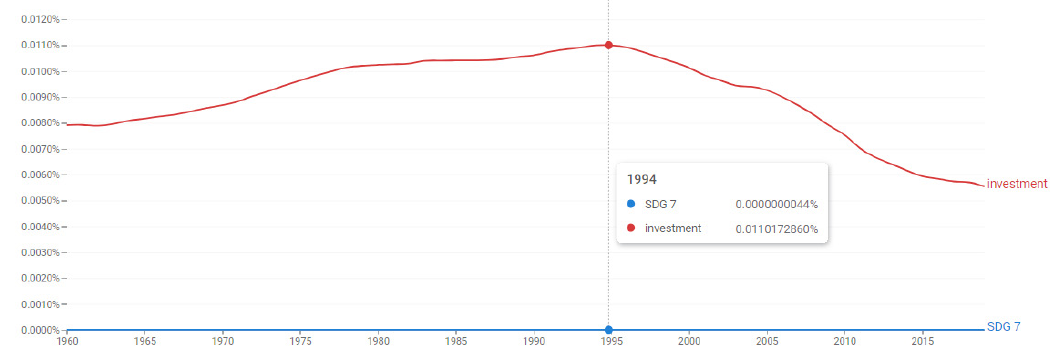
Figure 8. Ngram on the research terms of SDG 7 and Investment in 1960–2019